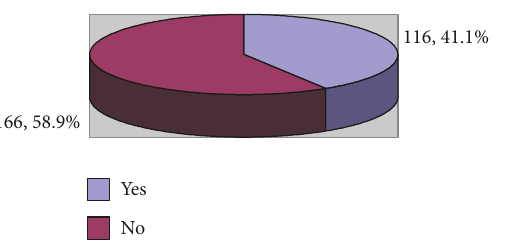
Figure 5: Prevalence of low personal accomplishment